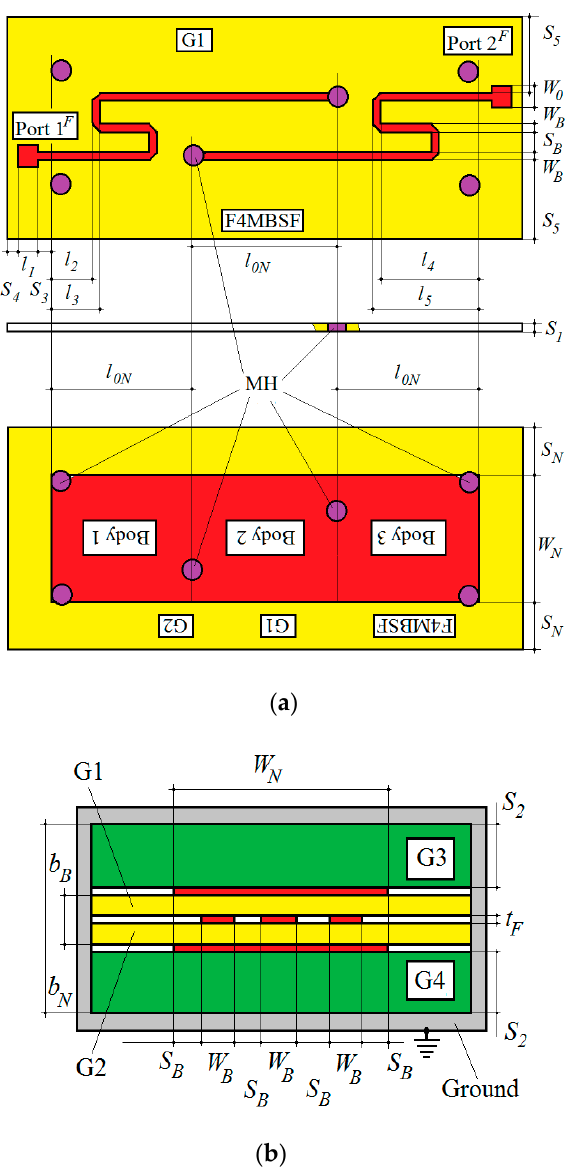
Figure 6. Architecture of the proposed four-layer reentrant bandstop filter: ( a ) face and bottom sides of the first thin central board (not drawn to scale; the abbreviation “MH” denotes the term “metallized hole”); note that the face side the second central board is realized without copper clothes, ( b ) cross-sectional view at the centre of body “1” after the corresponding reciprocal assemblage (not drawn to scale). F4MBSF:Russian thin film material.